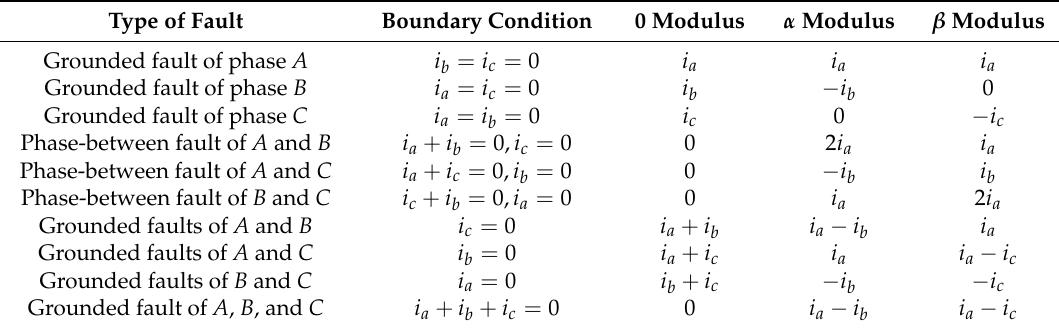
Table 3. Modulus components of α , β , and 0 for the different